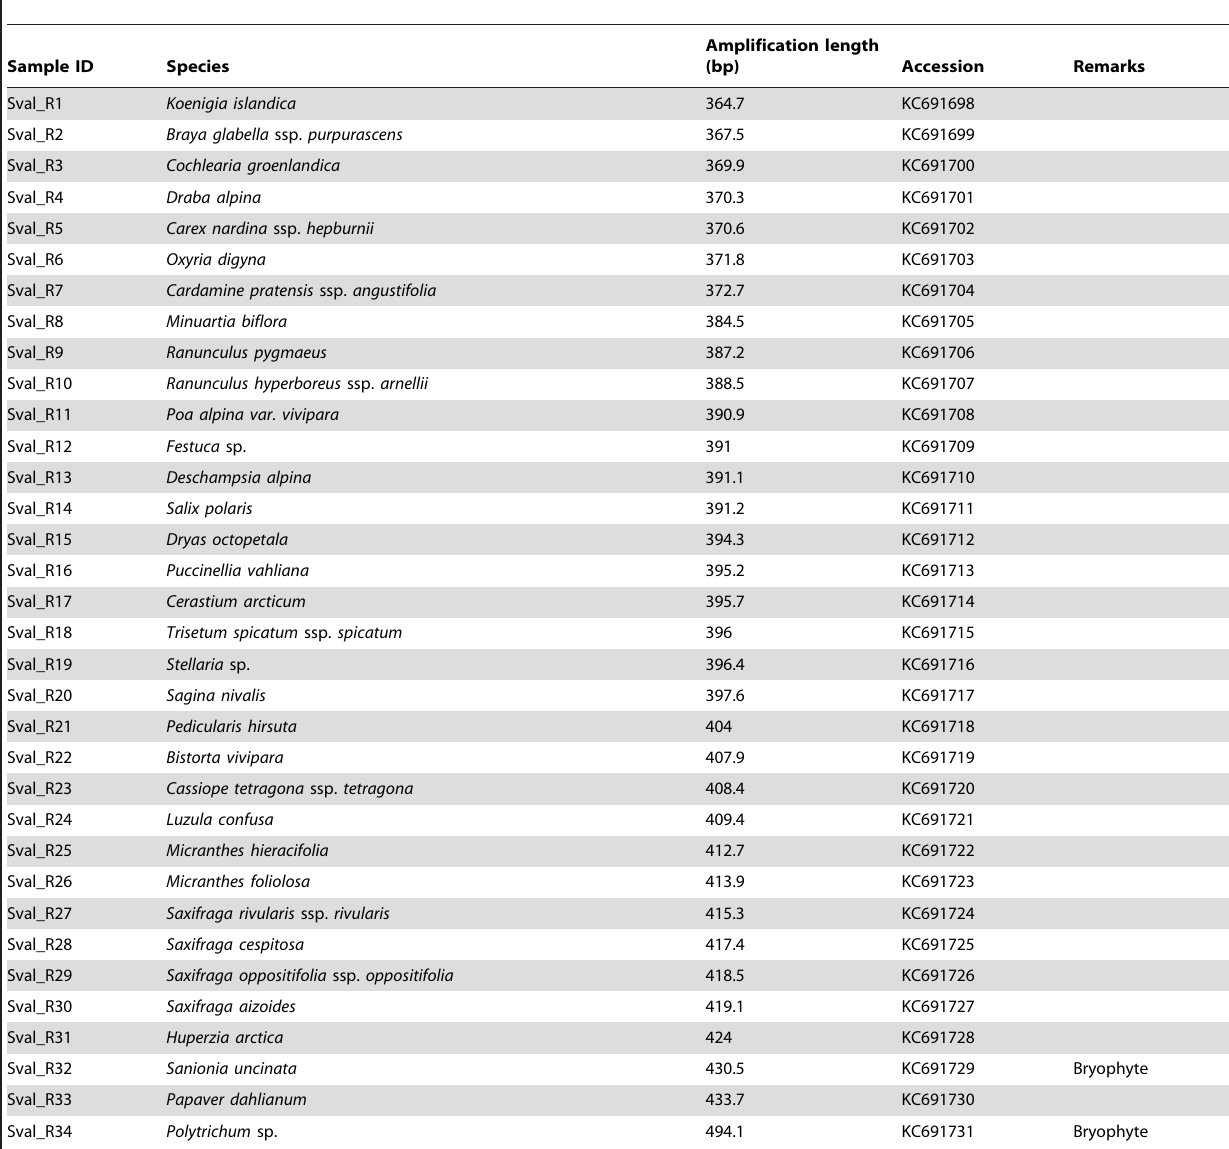
Table 1. Constructed LH database for 32 vascular plants and 2 bryophyte species living in Ny-A˚lesund (78 u 53’-78 u 55’N, 11 u 46’- 12 u 11’E), Spitsbergen Island, Svalbard in Norway.